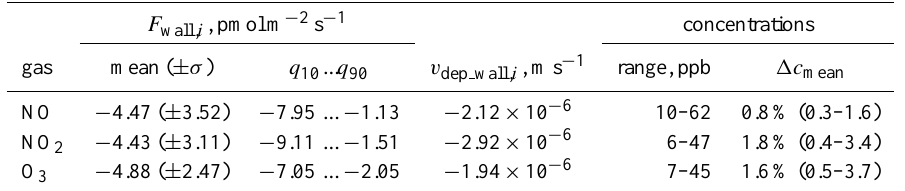
Table 6. Parameters of sorption effects to the inner chamber walls determined by laboratory experiments. q 10 and q 90 denote the 10% and 90% quantiles of the entire blank flux density F wall,i data, concentration ranges represent applied fumigation concentrations during the experiment, 1c mean denotes the mean concentration difference of incoming and outgoing chamber air in % (range of differences in %).